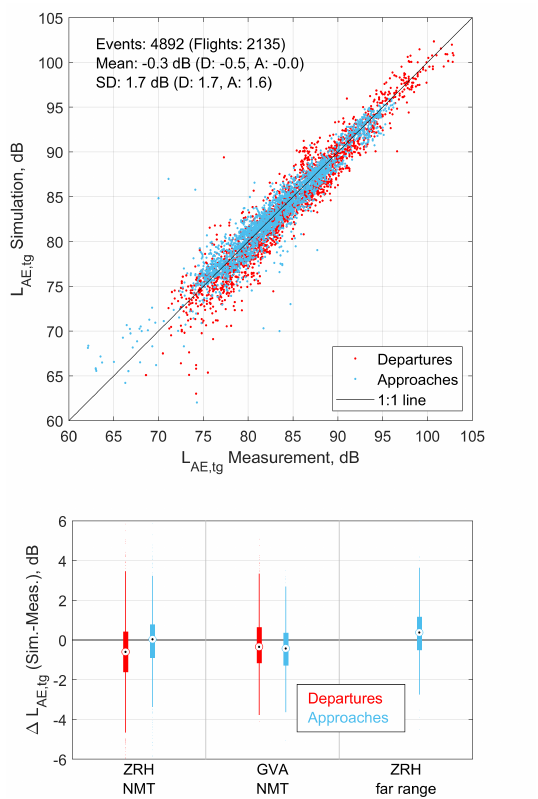
Figure 3: Comparison simulation vs. measurements for full models. Top: Scatterplot with all measurements (ZRH and GVA combined), grouped by procedure (D: Departure; A: Approach; SD: Standard de- viation). Bottom: Box-whisker-plots of the measurements, grouped by measurement origin and procedure.